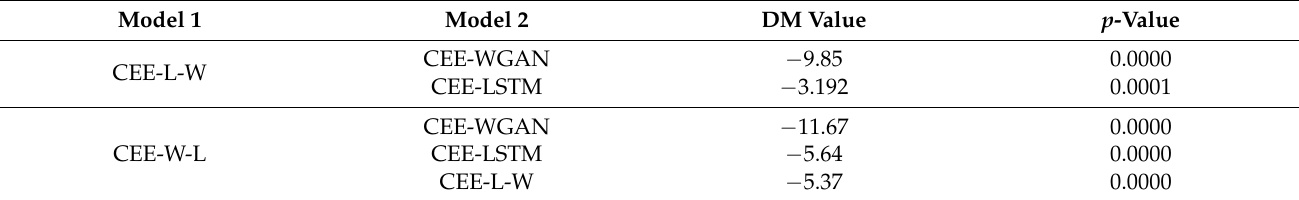
Figure 6. ( a ) Comparison of the MAE of the proposed model and that of the other decomposition- integration models. ( b ) Comparison of the MAPE of the proposed model and that of the other decomposition-integration models. ( c ) Comparison of the RMSE of the proposed model and that of the other decomposition-integration models. Table 6. Results of DM